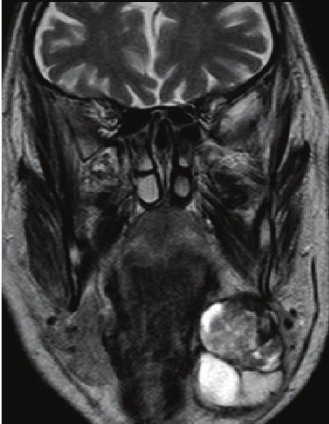
Figure 1: Preoperative MRI, coronal T2-W: 5 × 4 × 3cm mass originating from the left submandibular gland. Two different multi- lobed neoformations with colliquate areas (black square and black trapezius) delimited by a thick pathological peripheral tissue are clearly visible.